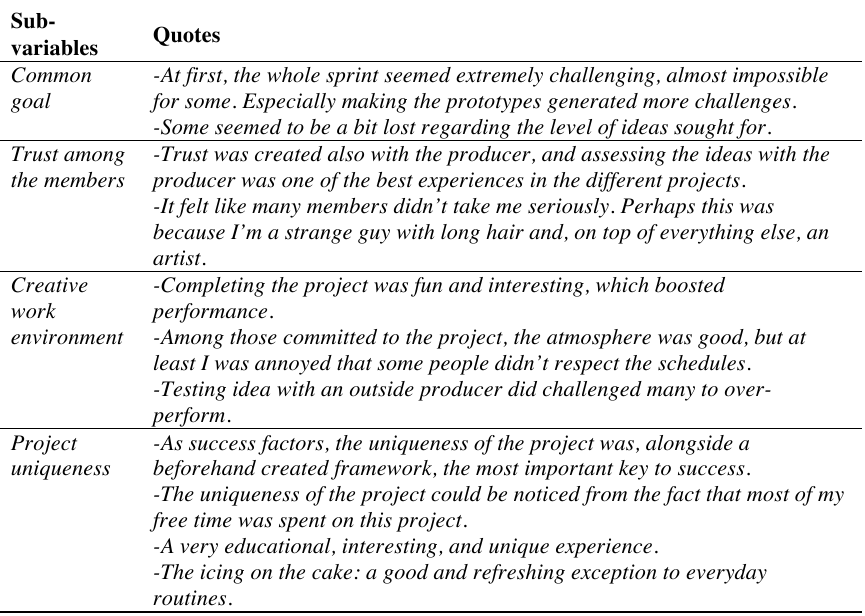
Table 4. Quotes related to team